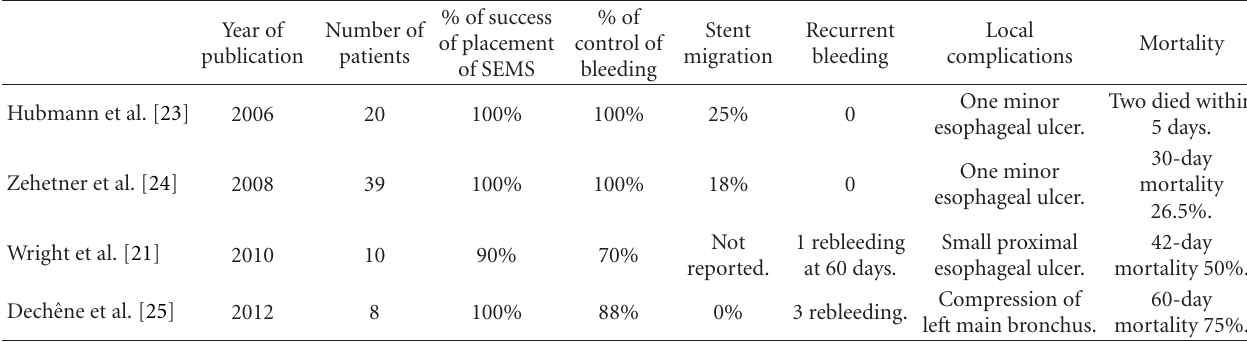
Table 1: Published series using SEMS for refractory esophageal variceal